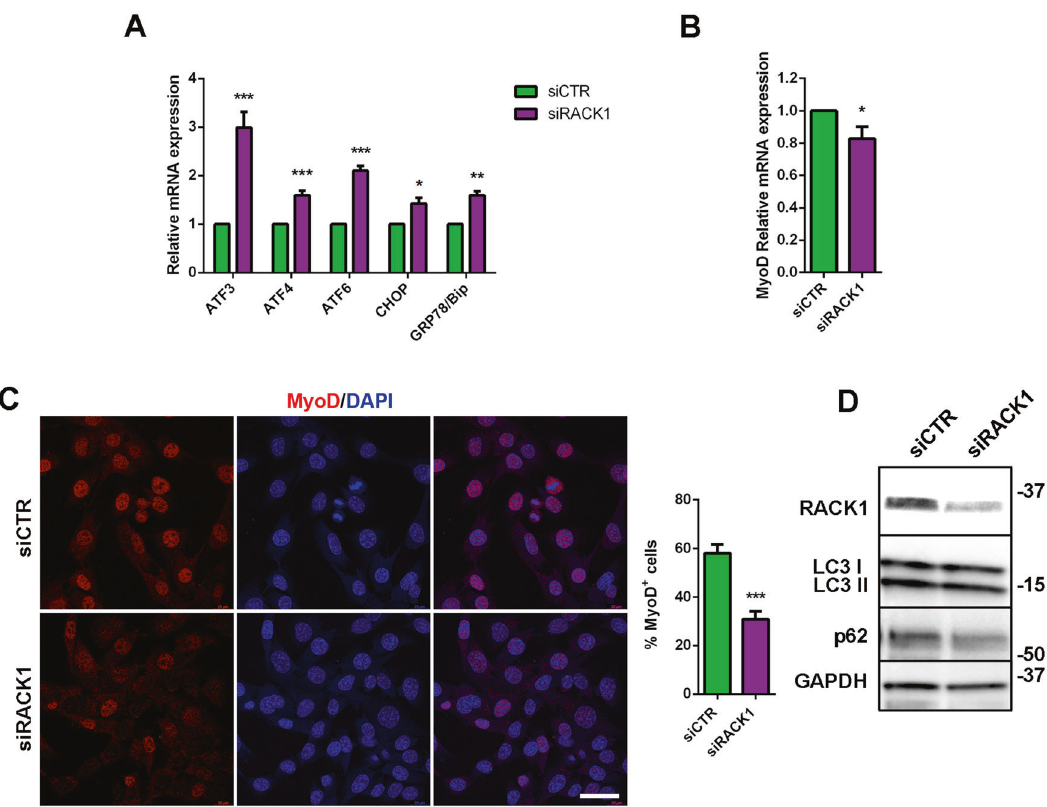
Fig. 7 RACK1 downregulation in mouse SC is associated to UPR response. SC were transfected for 24 h in proliferating (GM) conditions with a RACK1-speci fi c (siRACK1) or a non-targeting siRNA (siCTR), and then cultured for 24 h in differentiating (DM) conditions. A , B mRNA levels of UPR genes (ATF3, 4, 6, CHOP, and GRP78/Bip) and MyoD by RT-qPCR. Results are expressed as fold change of siCTR. C Confocal fl uorescence imaging of MyoD (red) and DAPI (blue) (scale bar: 40 μ m). Right panel: percentage of MyoD + cells on total DAPI-stained nuclei. D Western